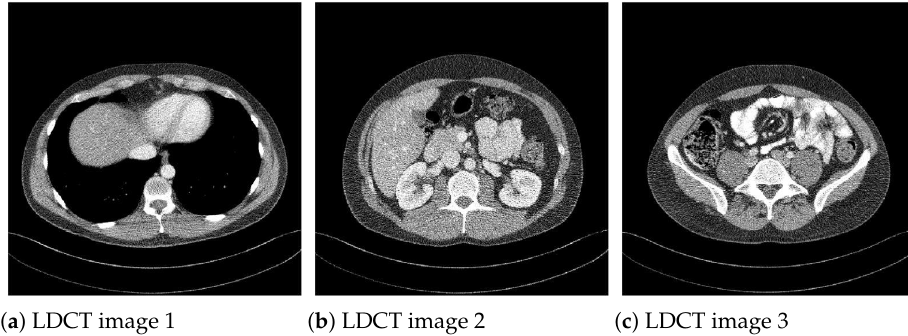
Figure 4. Low-dose (quarter-dose) abdominal CT medical images, 512 × 512